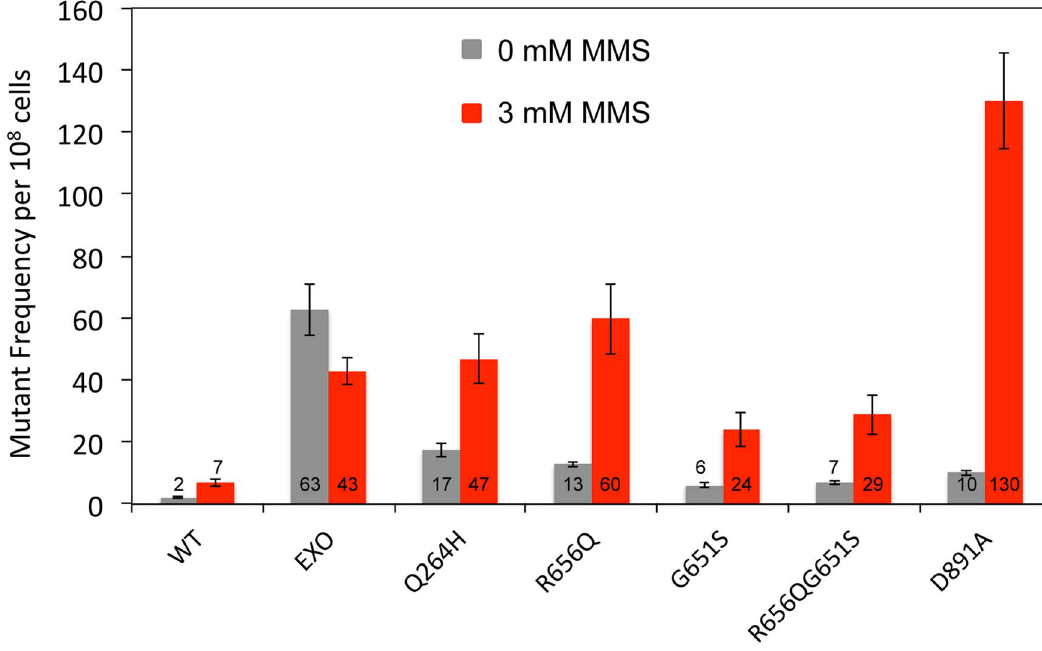
Figure 2. Mutations that disrupted Mip1 polymerase activity caused increased mutant frequency after MMS exposure. Median frequency ( 6 95% CI) of erythromycin-resistant mutants per 10 8 rho + cells of heterozygous diploid strains containing both MIP1 and mip1 with disease-associated mutation, exonuclease disrupting (EXO), or polymerase disrupting mutations in the presence (3 mM) or absence (0 mM) of MMS. Mutant frequencies were determined from at least 20 different independent cultures. CI, confidence interval; MMS, methyl